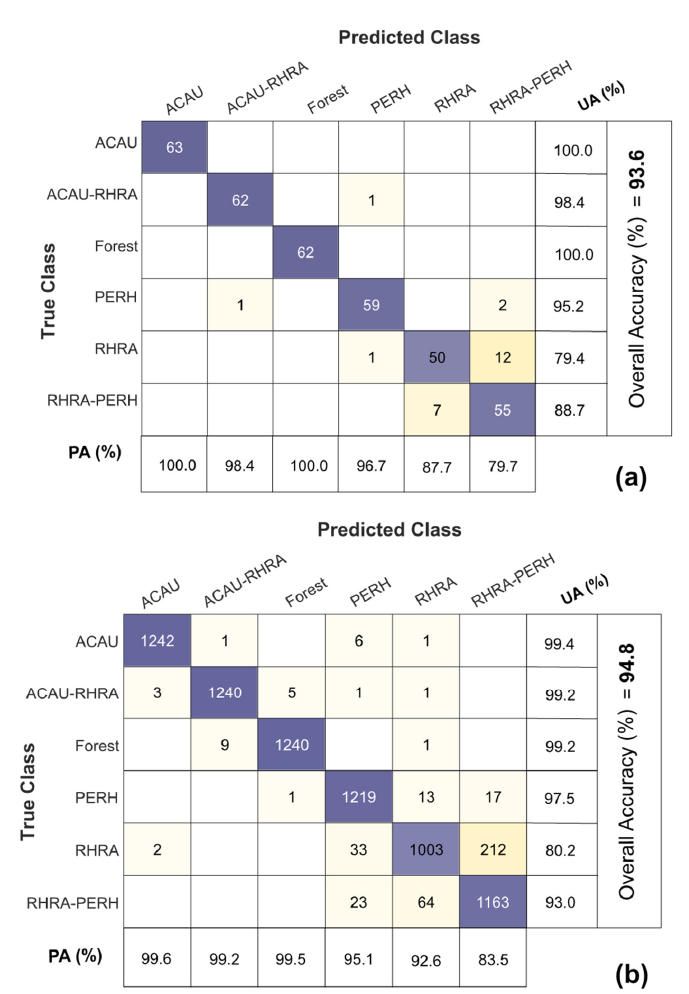
Figure 15. Confusion matrices for the best VNIR and SWIR classifications: ( a ) ME–VNIR (25 m) with the Q-SVM classifier; ( b ) SWIR reflectance (2.5 m) with the Q-SVM classifier. PA = Producer’s Accuracy; UA = User’s Accuracy.